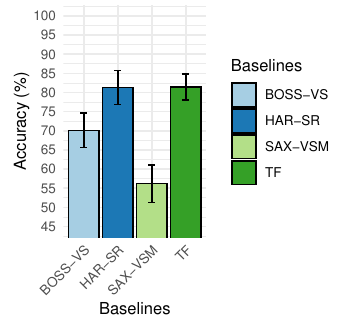
Figure 14. Average performance in E1 scenario.